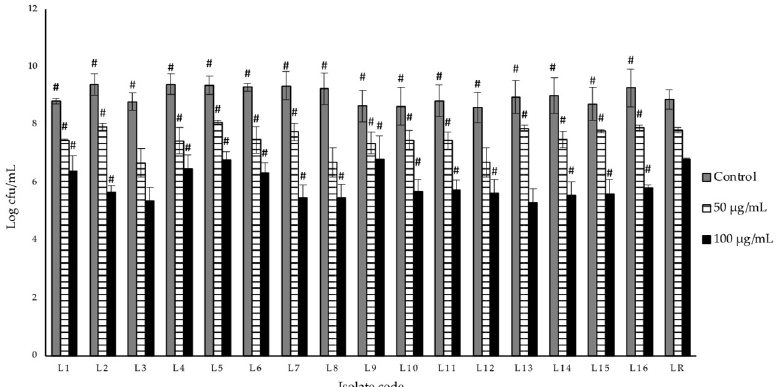
Figure 4. Survival of LAB in the presence of different concentrations of lysozyme. (Isolate code: L1–L16: Leuconostoc mesenteroides subsp. mesenteroides, LR: Lactobacillus reuteri Protectis DSM17938). The results are expressed as a mean ± SD of three independent experiments. Data points denoted with a # bear no statistically significant difference to LR.